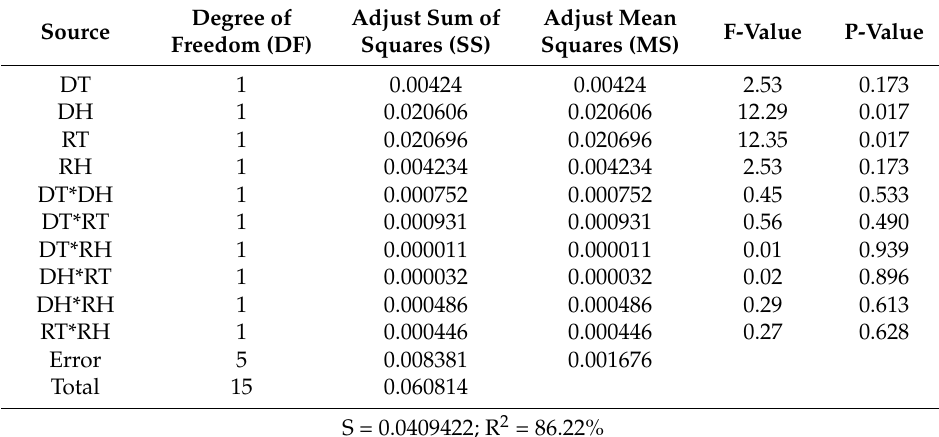
Table 3. Results of the analysis of variance (ANOVA) for Pt loading on the Pt/carbon paper composite